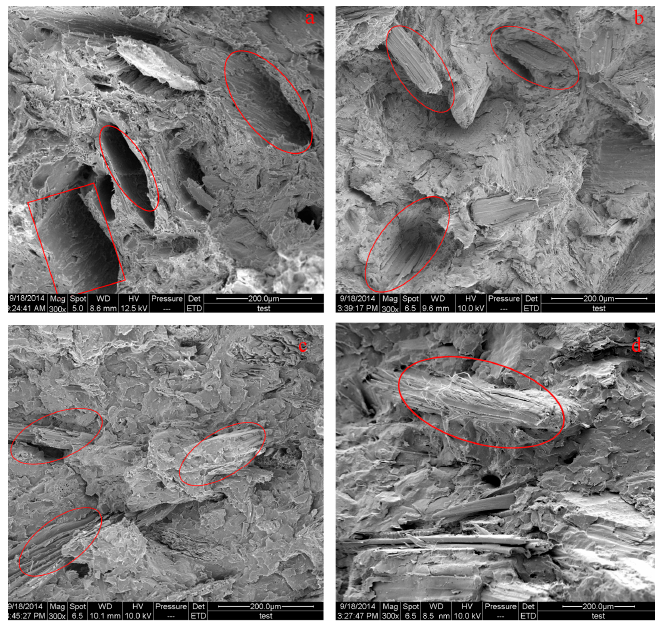
Figure 8. Scanning electron microscopy (SEM) micrographs of WPC prepared from untreated wood fibers and fibers modified through high-temperature high-pressure steam under different conditions: ( a ) untreated fibers; ( b ) T = 120 °C, p = 0.2 MPa, t = 5 min; ( c ) T = 170 °C, p = 0.8 MPa, t = 5 min; and ( d ) T = 170 °C, p = 0.8 MPa, t = 15 min.